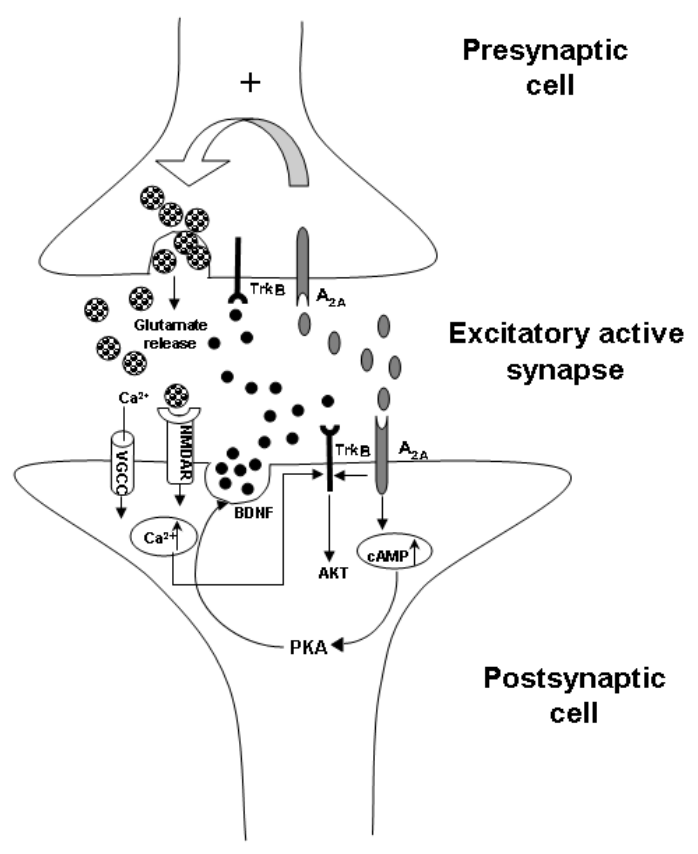
FIGURE 1. Scheme of the signaling involved in BDNF synaptic effects: role of